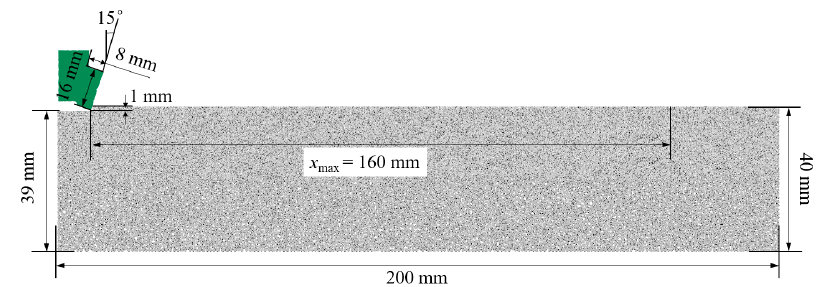
Figure 11. The PDC cu tt er and rock sample